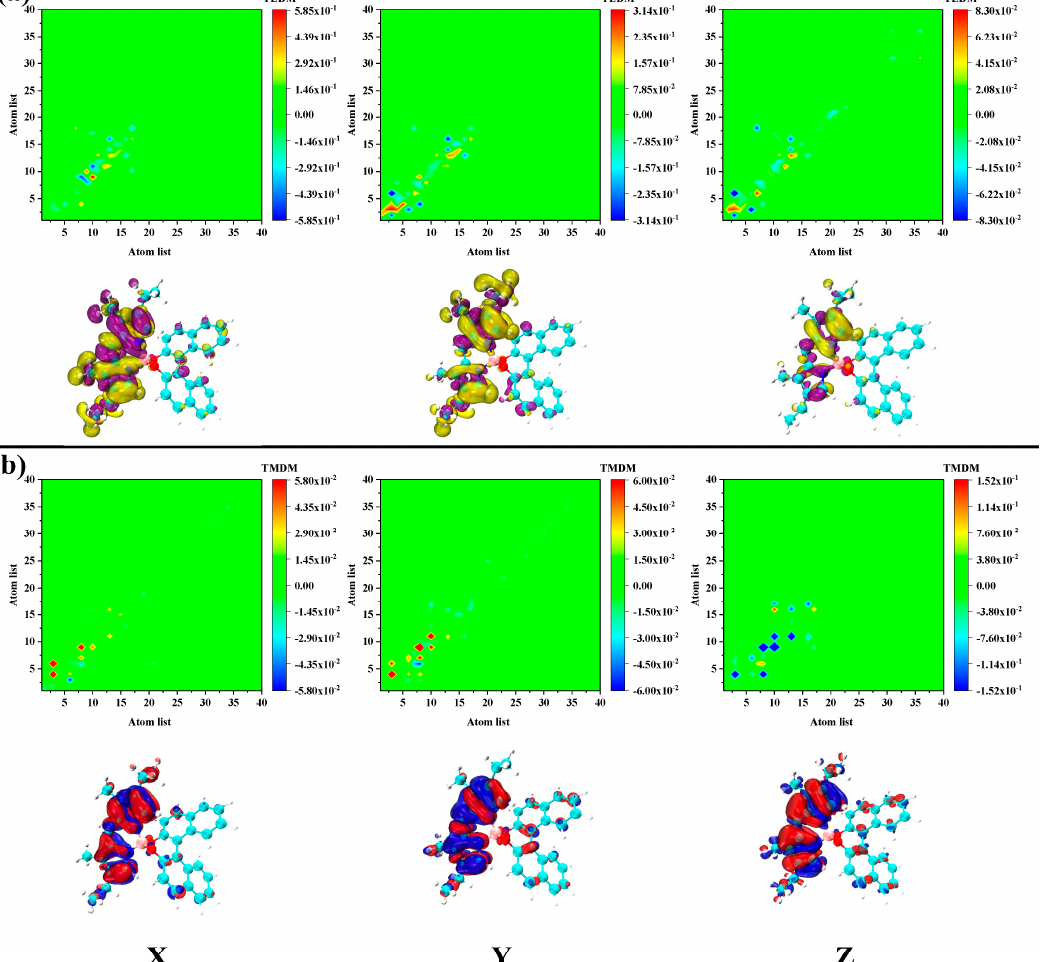
Figure 4. The transition electric ( a ) magnetic ( b ) dipole moment matrix (upper) and density (under) isosurface of S 1 in PM567. The yellow and purple isosurfaces represent the positive and negative transition electric dipole moments, respectively, and the red and blue isosurfaces denote the positive and negative transition magnetic dipole moments, respectively.